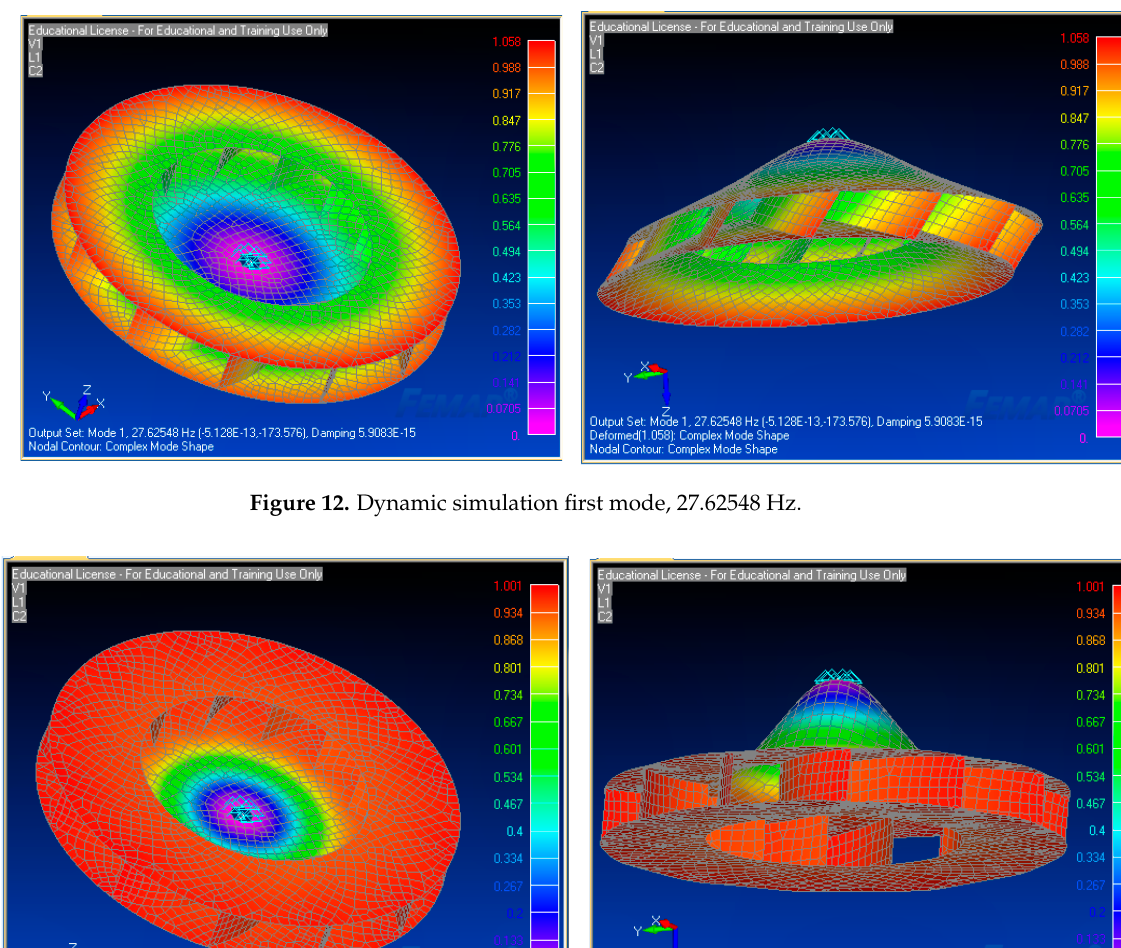
Figure 11. Meshed model of the impeller.